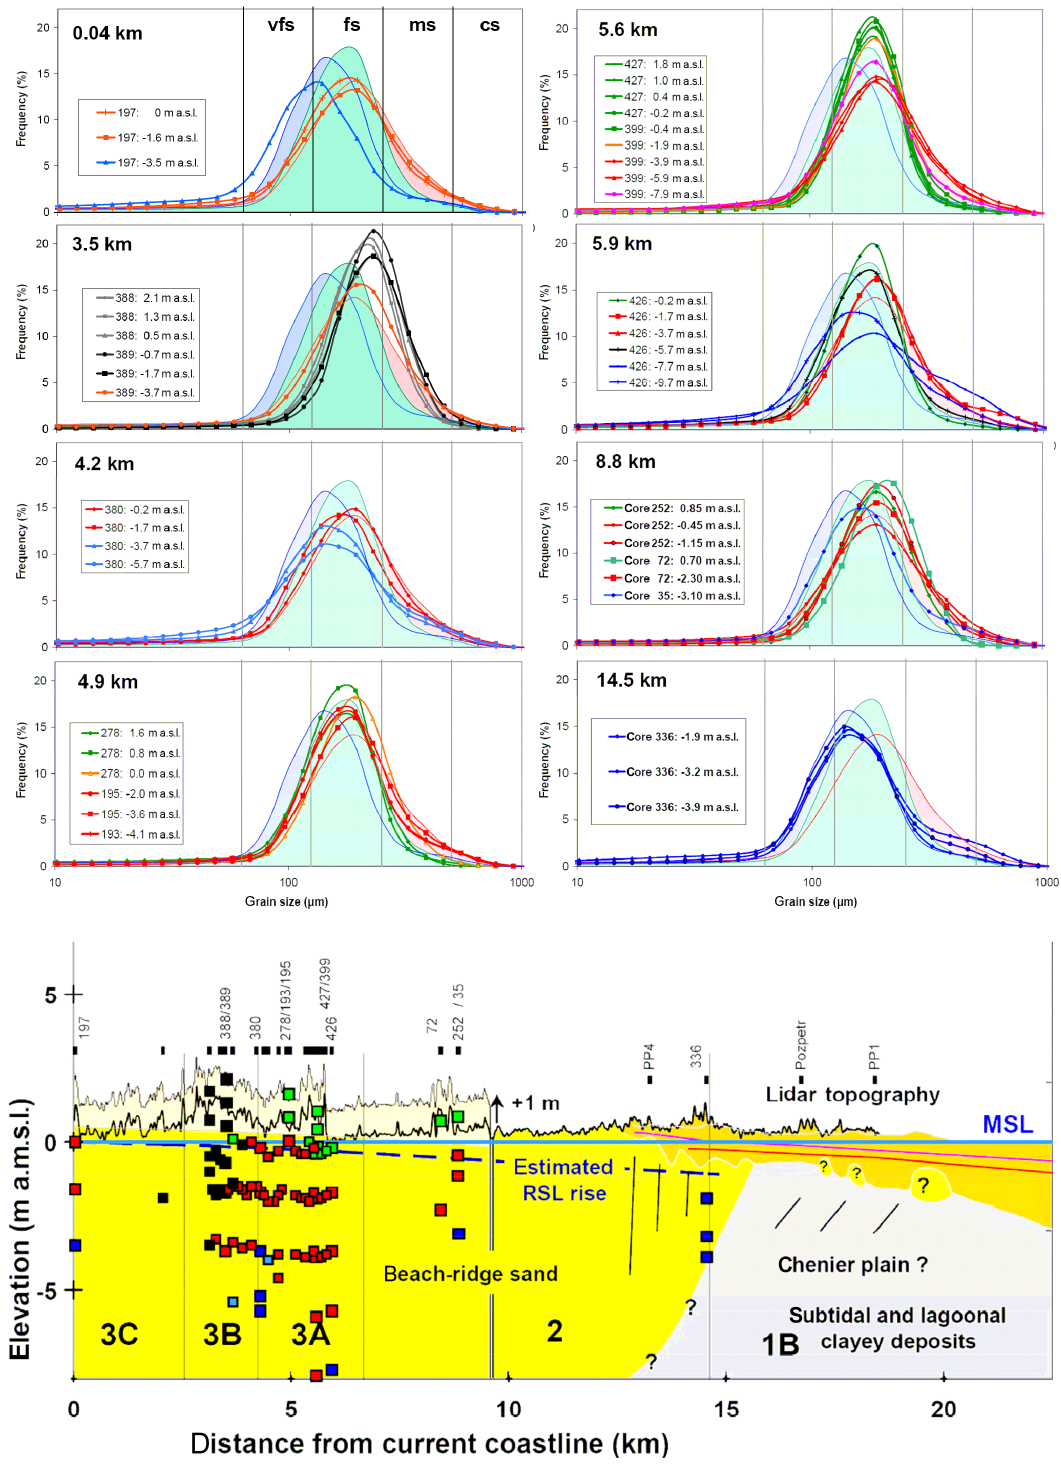
Figure B3. Variability in grain-size distribution of sand samples along Transect A at 0.04–14.5km from the current coastline. Vfs: very fine sand; fs: fine sand; ms: medium sand; cs: coarse sand. Grain-size distributions of representative surficial samples from the current beach profile (Fig. 7b) are indicated for